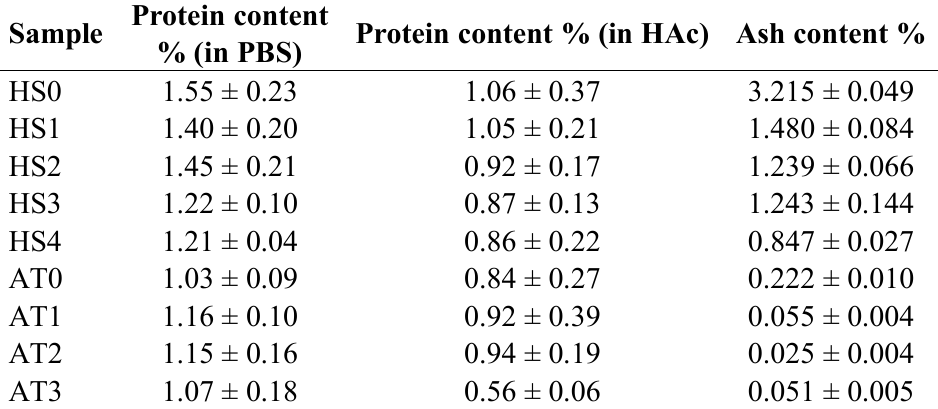
Table 4. Protein and ash content of deacetylated